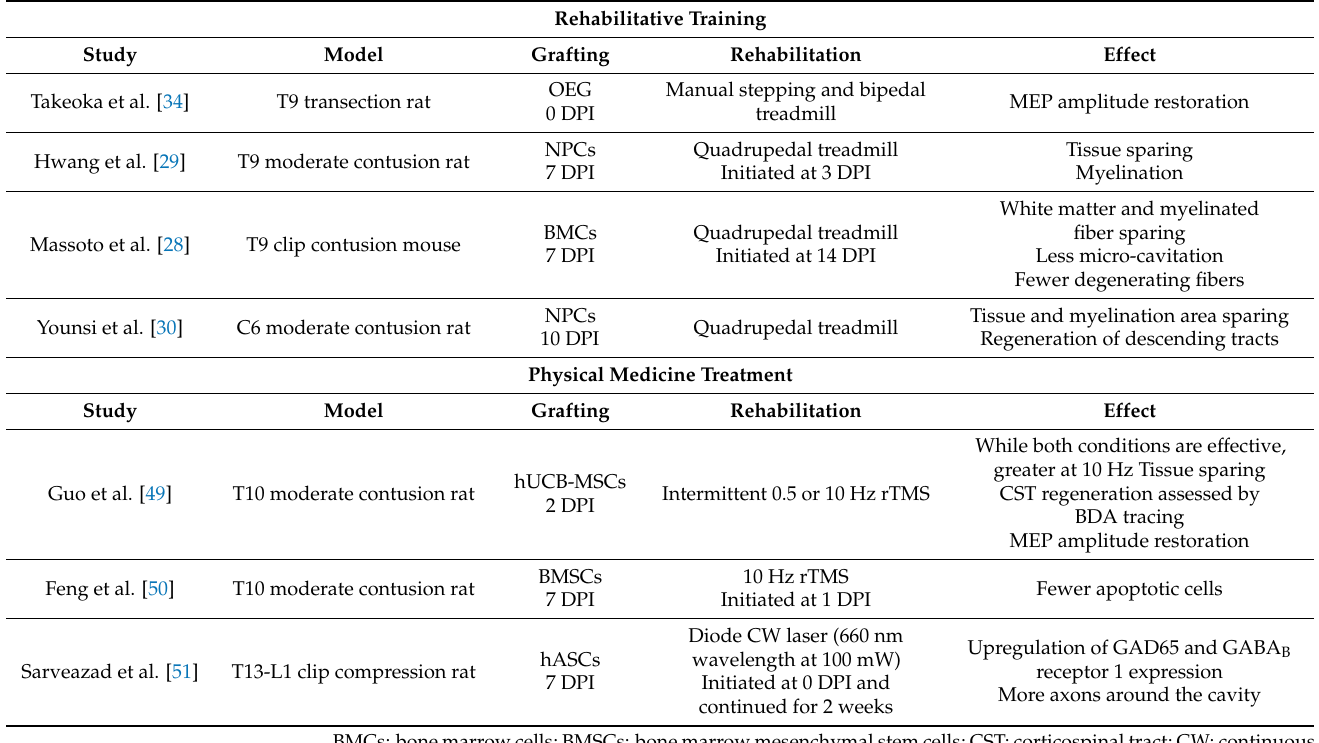
Table 2. Effects on the microstructure around the lesion.